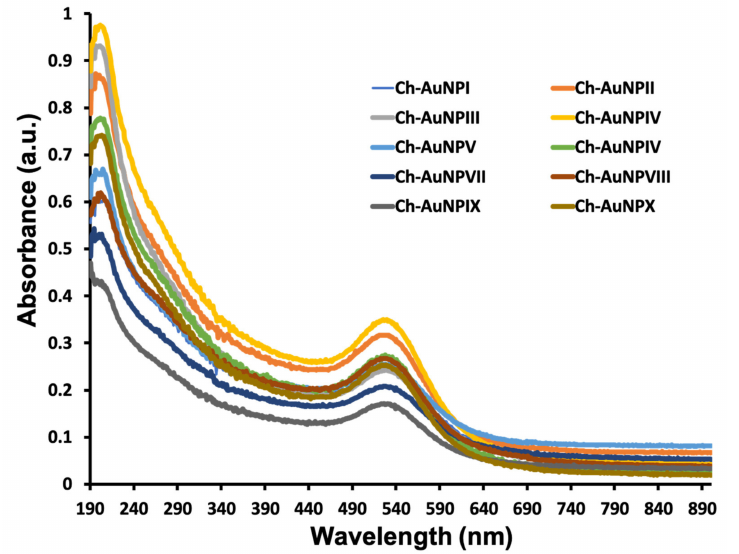
Figure 1. UV-Vis spectra of the as-synthesized Ch-AuNPs. The typical absorption region for AuNPs (500–600 nm) can be clearly witnessed with peak maxima centered about 520 nm. The spectra were almost similar for all the reaction conditions’ obtained